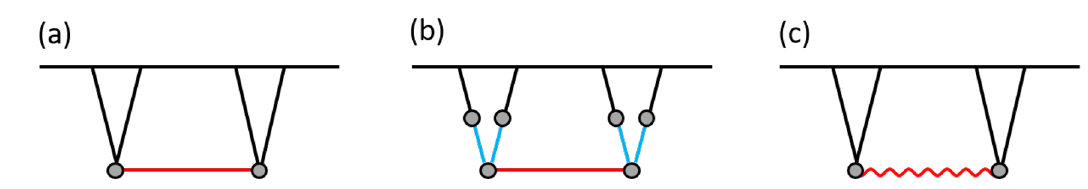
Figure 1 . Some typical diagrams one encounters in cosmological collider physics. They are 4- point diagrams with (a) an internal massive scalar propagator (red line), (b) an internal massive propagator (red line) and four massive propagators of another mass (blue line) on the external legs, (c) a massive vector propagator (red wavy